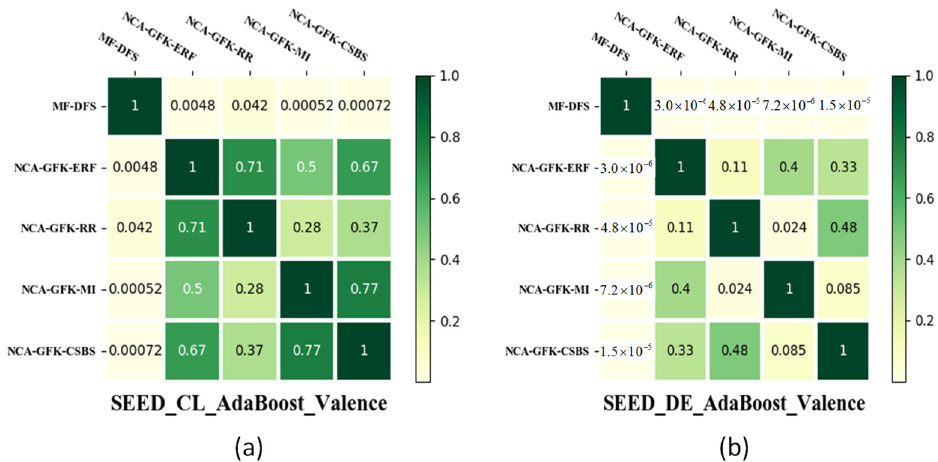
Figure 9. Heat map of the p -values of the paired t -test between different feature selection methods for the SEED database. The p -values of CL feature for the valence dimension are shown in ( a ). The p -values of DE features for the valence dimension are shown in ( b ).